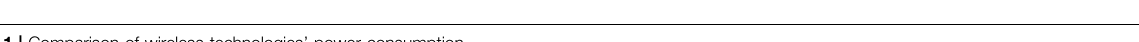
TABLE 1 | Comparison of wireless technologies ’ power